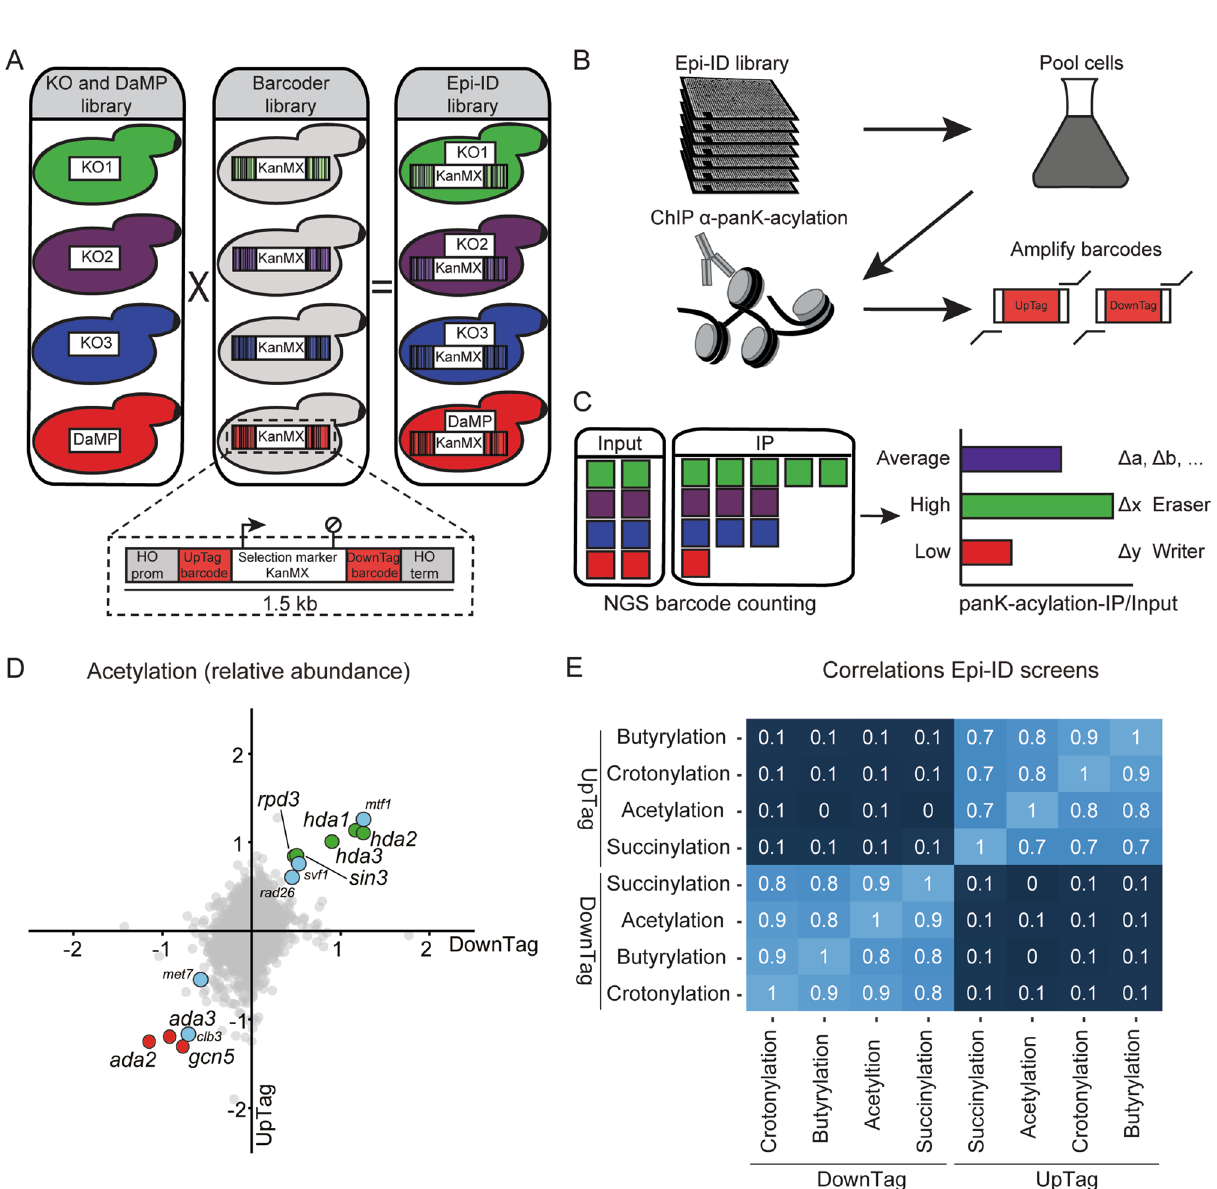
Figure 1. Epi-ID identifies regulators of chromatin. ( A ) Construction of the Epi-ID library. Knock-out and DAmP libraries of yeast mutants were crossed to a Barcoder library of yeast strains using SGA technology. Each strain in the Barcoder library contains a KanMX selection gene flanked by unique 20 bp UpTag and 20 bp DownTag barcodes integrated at the HO locus. ( B ) Outline of Epi-ID. Strains from the Epi-ID library were pooled, grown in liquid medium and subjected to ChIP using pan-K-acyl antibodies. The barcodes were amplified from ChIP and input DNA. ( C ) Next-generation sequencing of barcodes. Barcodes counted in immpunoprecipitates were normalized to counts in input. ( D ) Outcome of Epi-ID for acetylation on approximately 6500 mutant strains. Scatter plots present log2-transformed acetyl ChIP/input ratios normalized to H3 ChIP/input ratios for UpTag versus DownTag. Averages of two independent Epi-ID screens are shown. Each dot represents a single mutant strain. Mutants of the ADA (red), RPD3 (green), HDA1 (green) complexes and newly identified mutants selected for follow-up (blue) are highlighted. ( E ) Spearman correlations plotted for all Epi-ID screens, unnormalized for